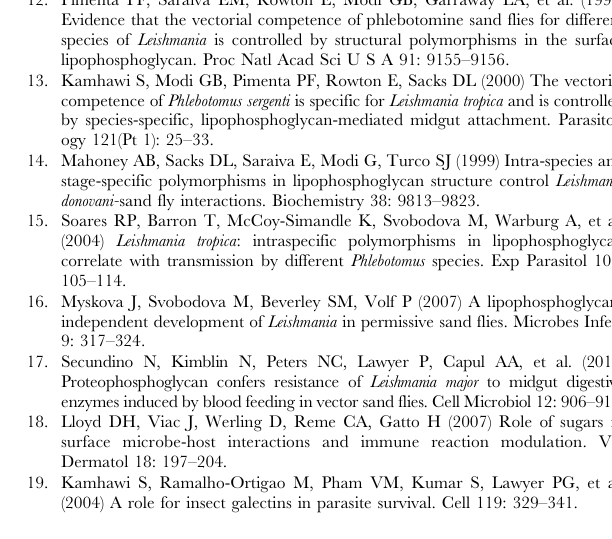
Table S4 Secreted acid phosphatase (SAP) levels in Leishmania procyclic promastigote culture